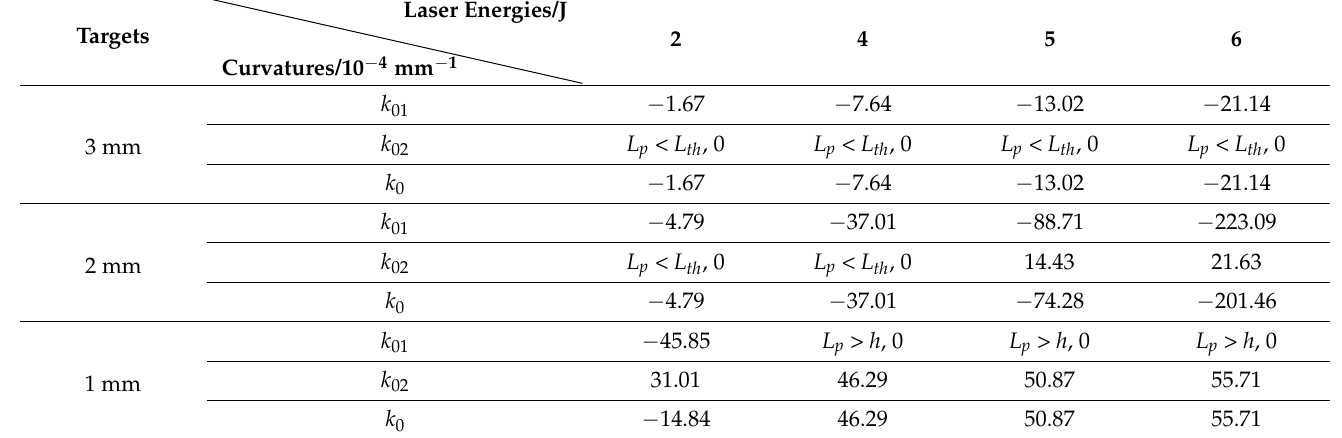
Table 1. Curvatures k 0 of the target sheets calculated using the analytical model.